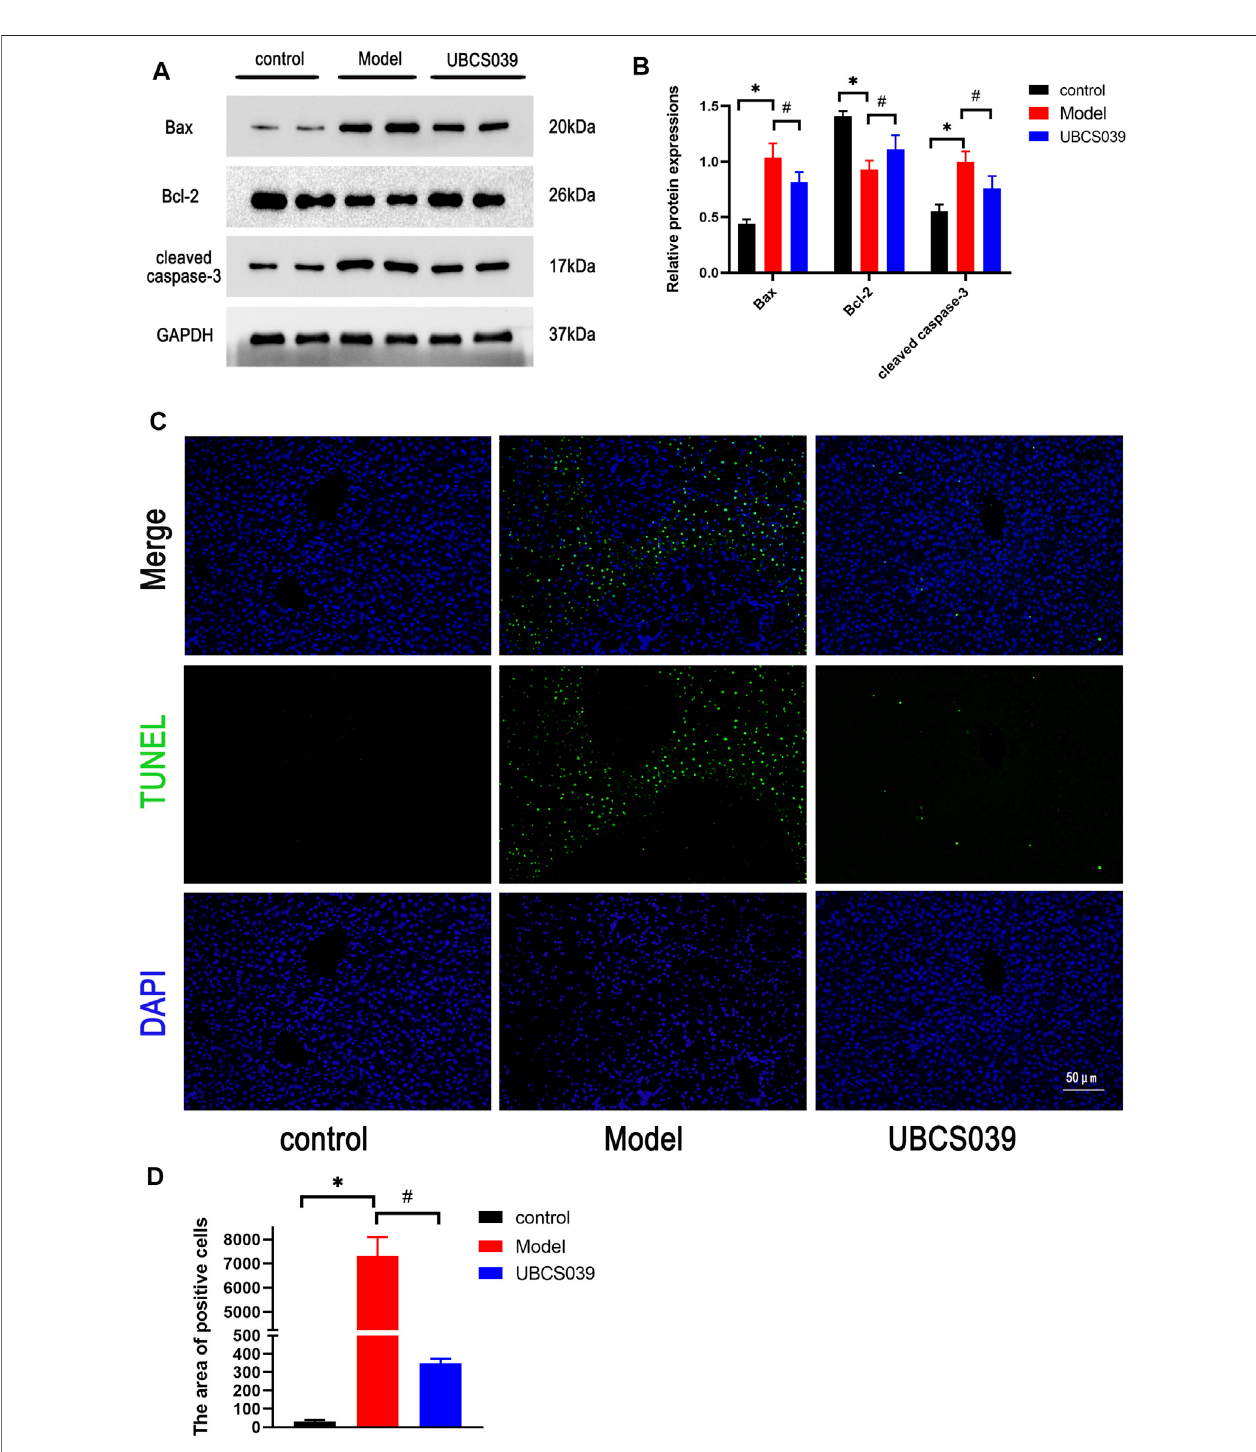
FIGURE4| EffectsofUBCS039onhepatocytedeathinliversamples. (A) WesternblottingwasusedtoanalyzetheexpressionsofSIRT6,Bax,Bcl-2,andcleaved caspase 3inliver tissue. (B) Densitometric analysisofrelative proteins. (C) TUNELstainingdetected the number ofapoptosis cells inliver sections. * p < 0.05,compared with the control group. # p < 0.05, compared with the model group. n = 5 per group. Data are represented as mean ± SD.